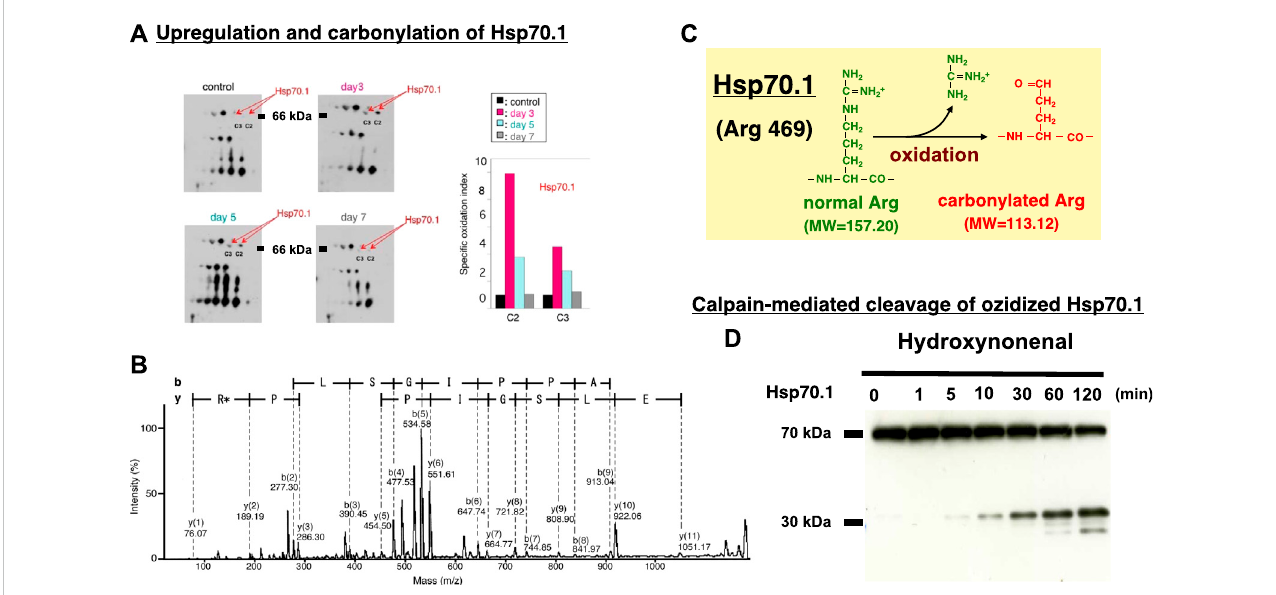
Upregulation, oxidation, and cleavage of Hsp70.1 after transient brain ischemia. Panel (A) Two-dimensional gel electrophoresis with immunoblot detection of carbonylated protein analysis (2D Oxyblot) of the postischemic hippocampal CA1 tissues after immunoprecipitation with anti-Hsp70.1 antibody, shows upregulation of carbonylated Hsp70.1 on the postischemic days 3 (pink) and 5 (blue), compared to the control (black). The speci fi c oxidation index is signi fi cantly high on days 3 and 5. Panel (B) Matrix-assisted laser desorption ionization-time of fl ight/time of fl ight (MALDI-TOF/TOF) analysis of the upregulated spots with the Mascot search. Both the peptide sequence of the carbonylated peptide ion (459-FELSGIPPAPR*G-470) and the presence of y2 fragment ion atm/z 113.12, indicates that carbonylation occurred at Arg469 inHsp70.1.R*: Carbonylated arginine Panel (C) Inresponse to hydroxynonenal being generated by ROS, carbonylation occurred at the key site, Arg469 of Hsp70.1. A decrease of its molecular weight from 157.20 to 113.12 is compatible withtheinsultofcarbonylation(PanelsA,B,C:citedfromOikawaetal.,2009).Panel (D) In-vitro cleavageofHsp70.1byactivated μ -calpaininbraintissuesfrom the non-ischemic monkey. It is likely that hydroxynonenal-induced carbonylation facilitates calpain-mediated cleavage of the carbonylated Hsp70.1. Reprinted with permission from Sahara and Yamashim (2010); Yamashima et al. (2014).